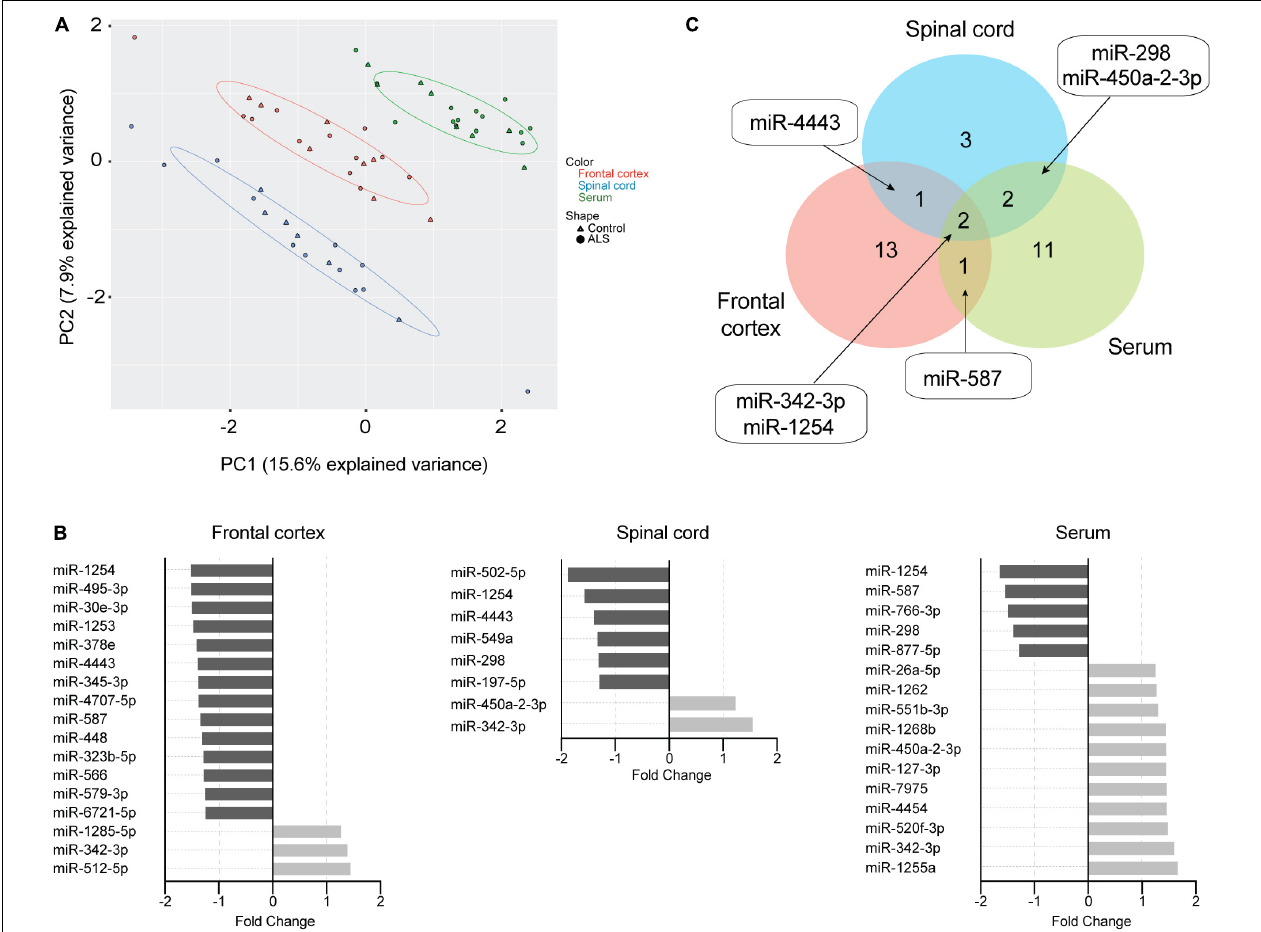
FIGURE 3 | EV miRNAs are dysregulated in ALS frontal cortex, spinal cord, and serum. (A) Principal component analysis plot of unsupervised clustering of EV miRNA signal. (B) Fold-change of significant ( P < 0.05) mature EV cargo DEmiRNAs was determined in ALS versus control groups. Increased fold-changes are represented in gray, while decreased fold-changes are represented in black. (C) Venn diagram showing common dysregulated EV-derived miRNAs from different ALS tissues. Frontal cortex (ALS = 12, Control = 8), spinal cord (ALS = 12, Control = 6), and serum (ALS = 14, Control = 8).